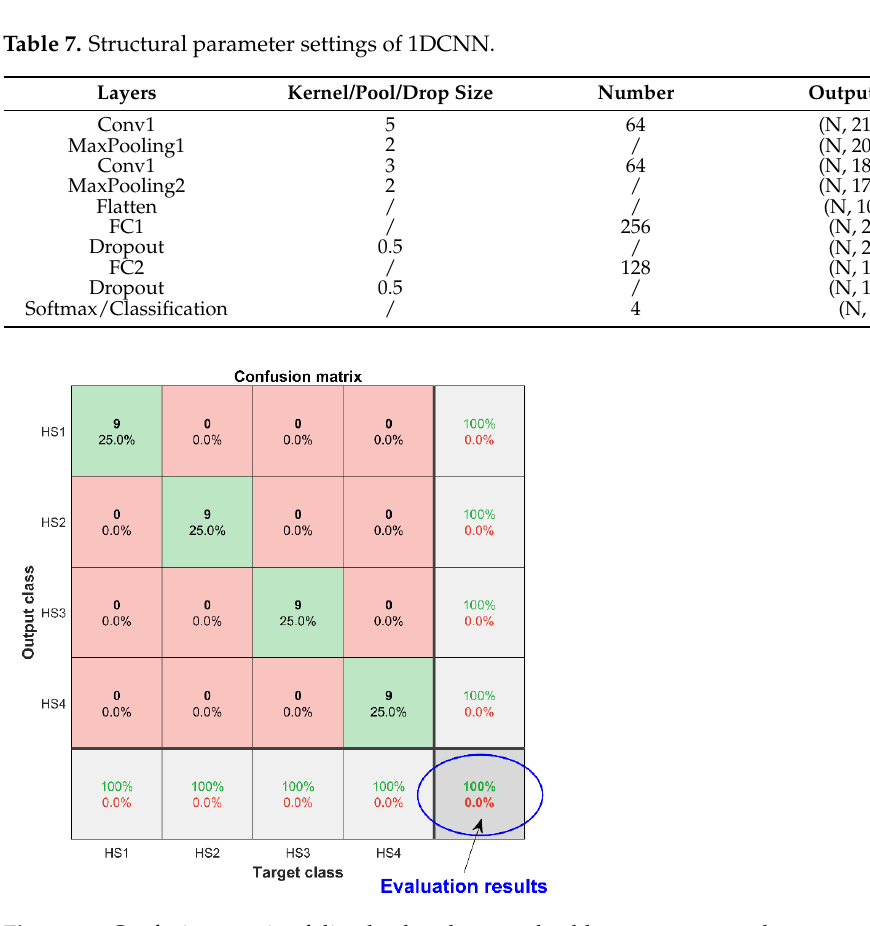
Figure 12. Confusion matrix of diesel valve clearance health assessment results.